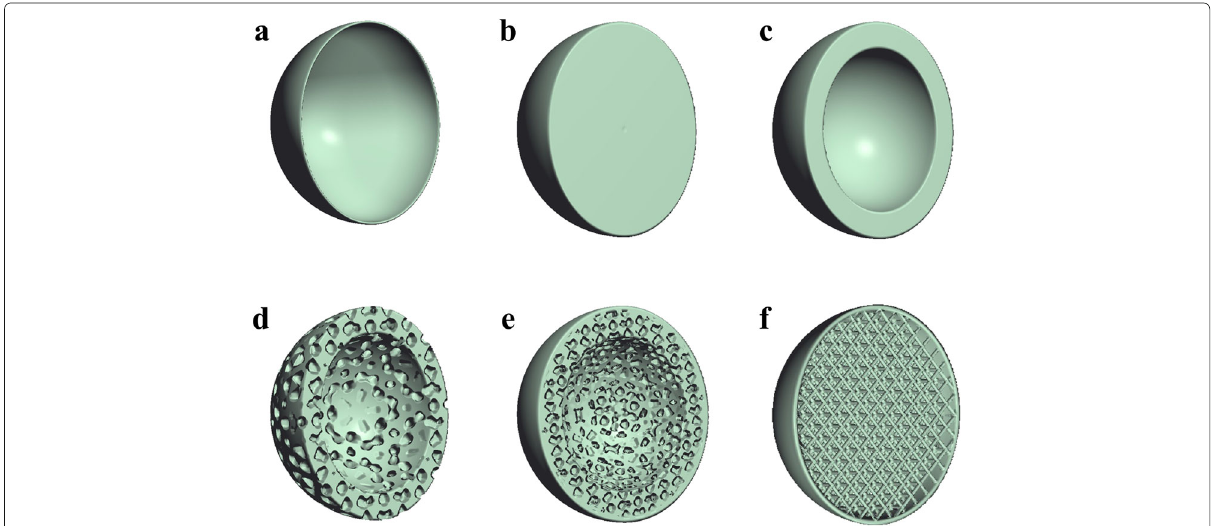
Fig. 1 Some simple implicit models to demonstrate the fact that implicitly represented geometric objects are 3D printing ready. These examples show that an implicitly modeled geometric object can not only provide an exterior appearance of an object, but more importantly, it can be associated with a volumetric solid object to provide detailed descriptions about the object’s interior structure and material properties. a . Surface representation. b . Solid representation. c . Solid boundary representation. d . Porous material structure. e Solid boundary with porous interior materials. f . Thin solid surface with interior supporting